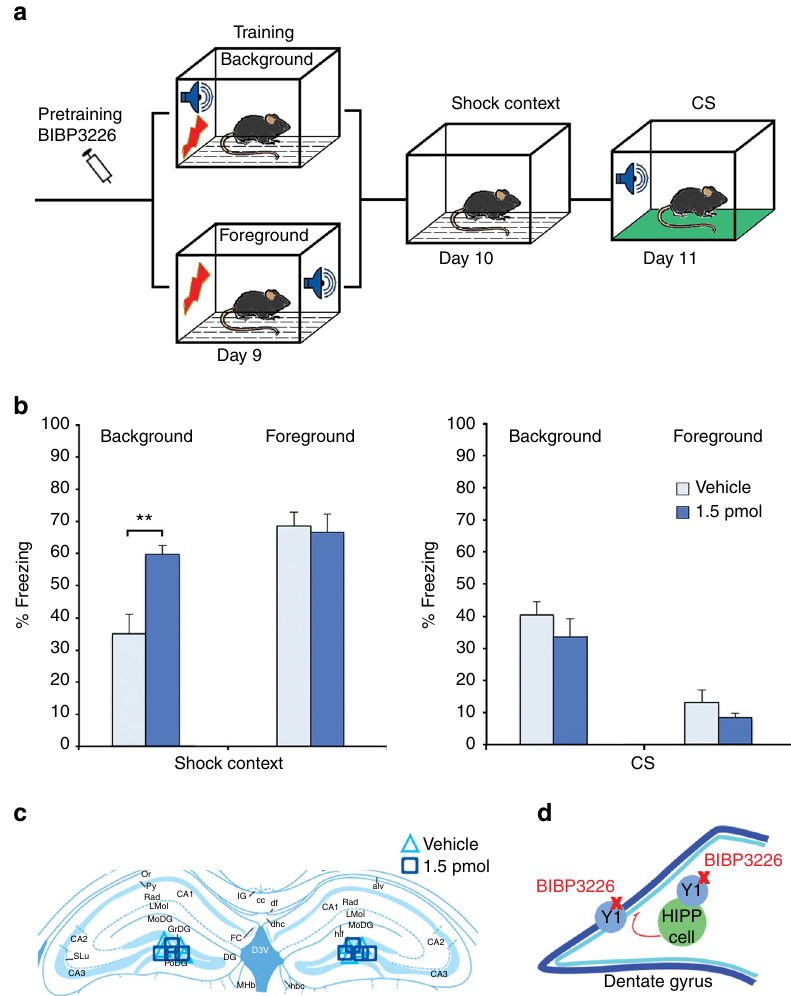
Fig. 3 NPY in the dorsal DG controls background context fear memory. a A schematic of the behavioral paradigms. b Blocking Y1 receptors with BIBP3226 (1.5 pmol per hemisphere; n = 9) during training increases background context conditioning compared to vehicle ( n = 11). BIBP3226 treatment does not induce any change, when used in foreground context conditioning (vehicle n = 7; 1.5 pmol BIBP3226 n = 8). No effect is observed on auditory fear memory, as the background context group maintains unchanged cue responding after injection, while the foreground context group continues to show only low levels of freezing. c Localization of guide cannulas in the dorsal DG. d A schematic of the proposed local circuit and site of drug activity. Data are means + s.e.m. Statistical analysis was done with Student ’ s unpaired t -test. ** P <